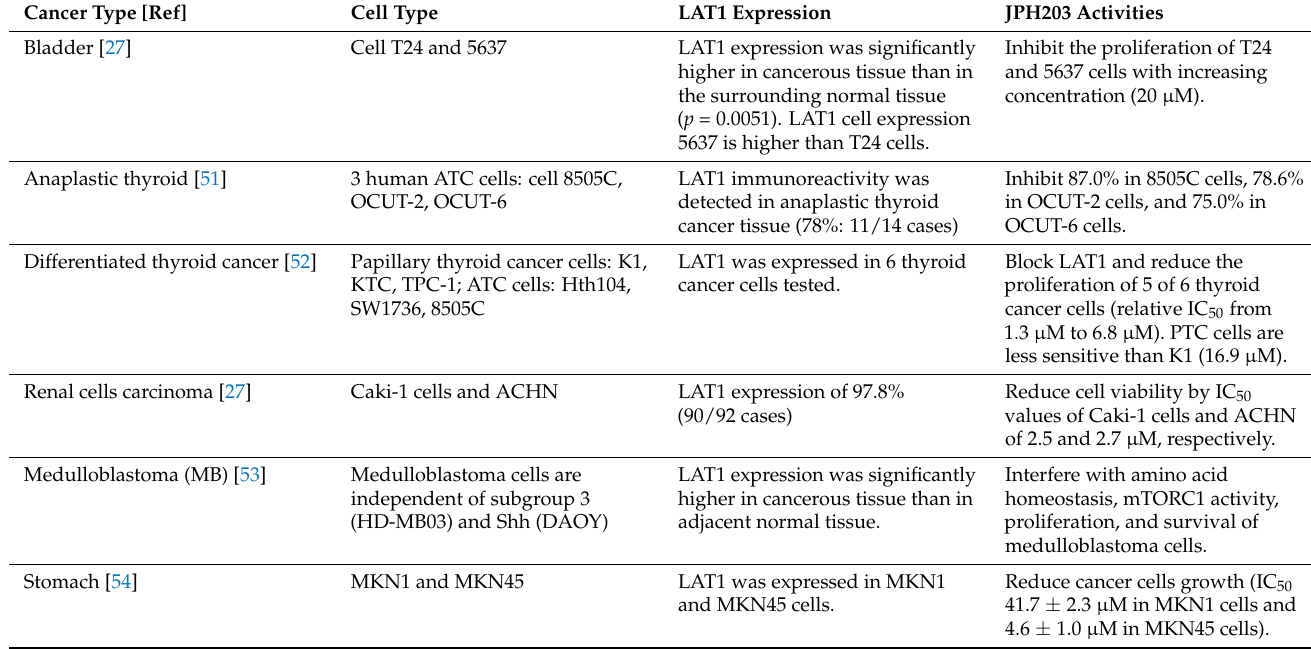
Table 1. In vitro